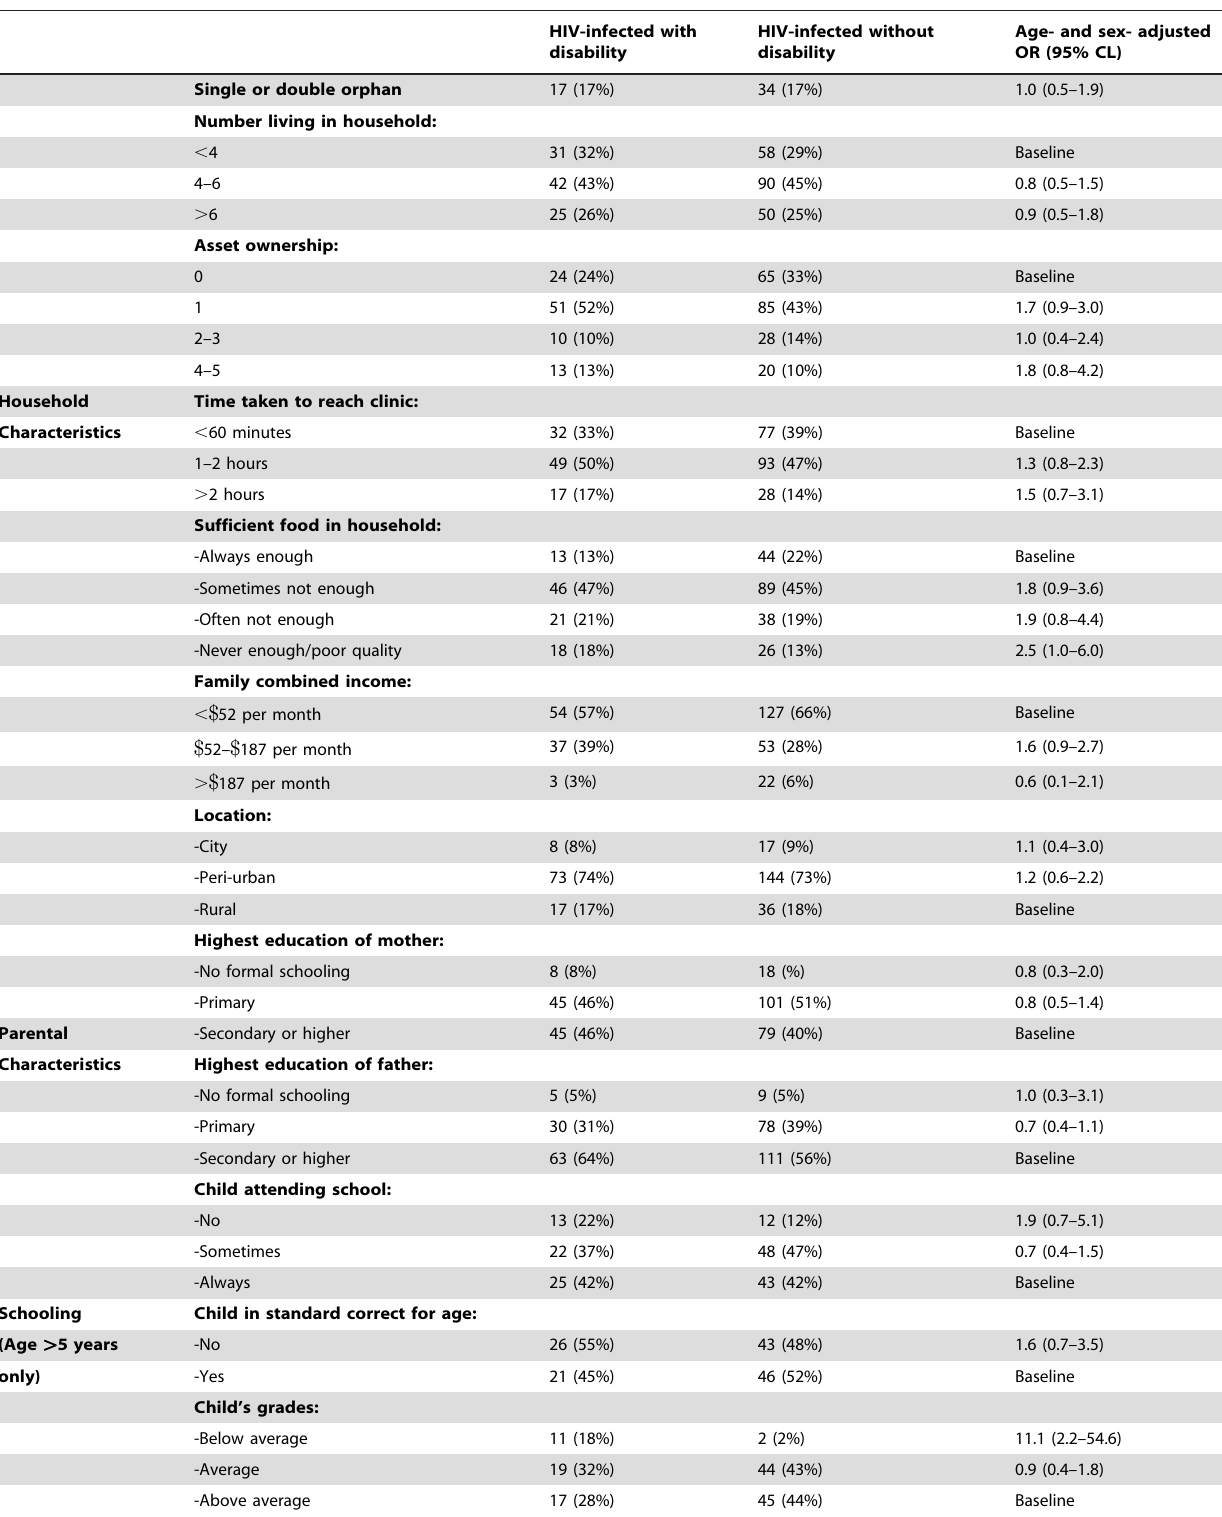
Table 5. Sociodemographic characteristics of HIV-infected children with relation to